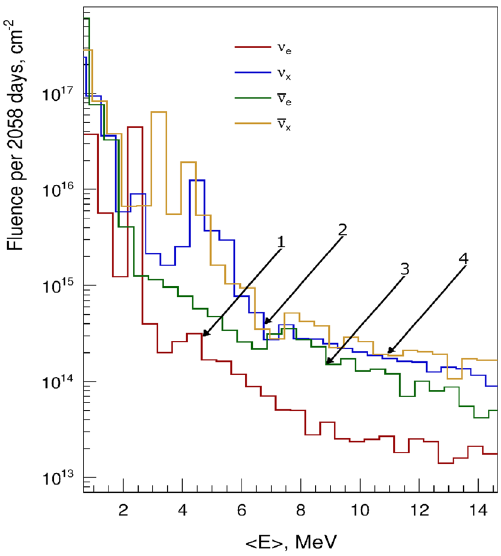
Fig. 6 Upper limits on the fluences of ν e ,μ,τ and ¯ ν e ,μ,τ with supernova neutrino spectra obtained from the spectral fit (90% C.L.): 1 – ν e , 2 – ν μ,τ , 3 – ¯ ν ¯ ν μ,τ e , 4 – the 90% C.L. upper limit in the 13.6–16.8 MeV interval is N lim = 2 . 44. The relation N x ≤ N lim was converted into the obtained fluence limits for all neutrino flavors given in Fig.7formonoenergeticneutrinosandinFig.8forsupernova neutrinos. The Figs. 7 and 8 also show the expected spectra of recoil electrons for the (ν, e ) -elastic scattering reactions = 30 MeV and (cid:10) E (cid:11) = 15 . 6 MeV. for E ν x